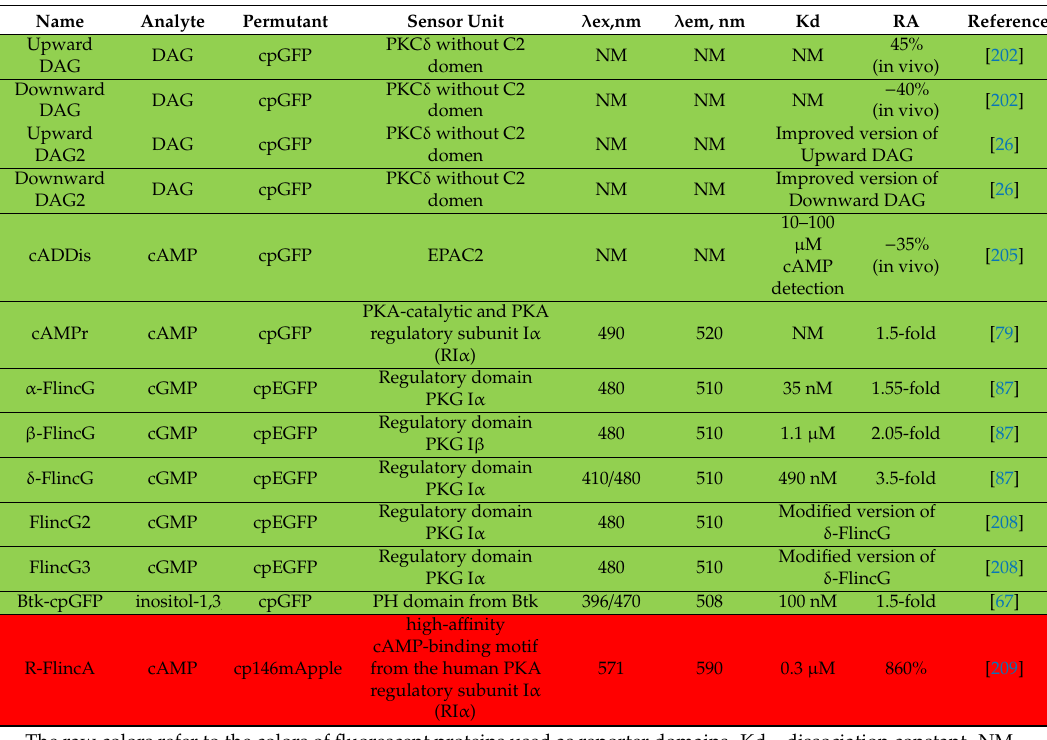
Table 6. GEFIs for secondary messengers